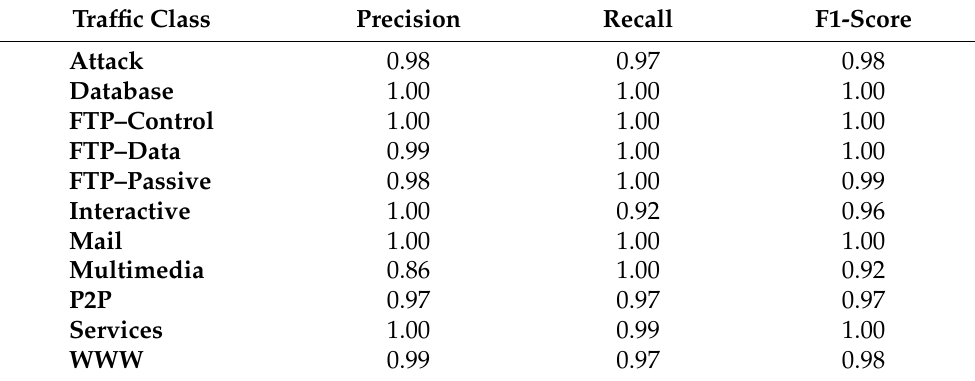
Table 4. Precision, recall, and F1-score per class for RF classification.